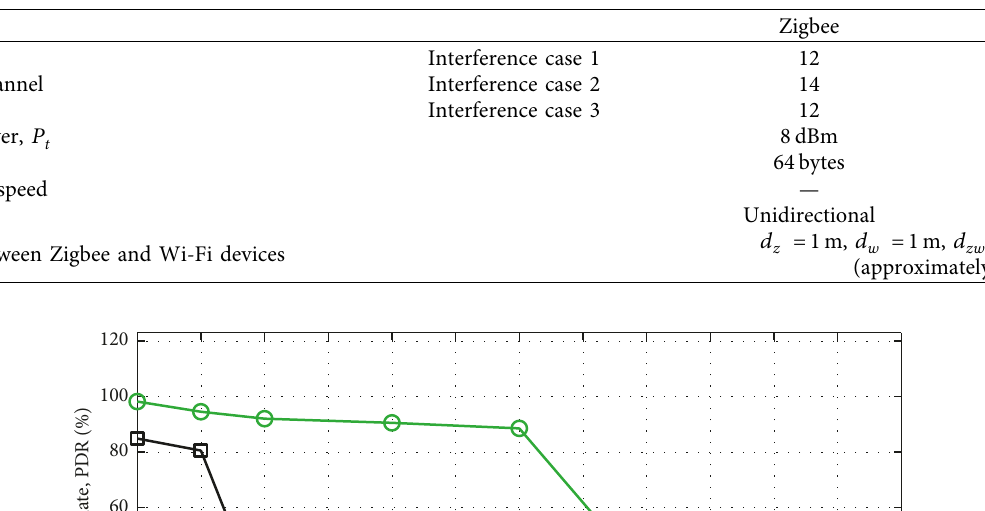
Figure 7: PDR vs d z without nearby Wi-Fi transmissions. Table 6: Parameters for the experiments in Section 4.2.2 (2).